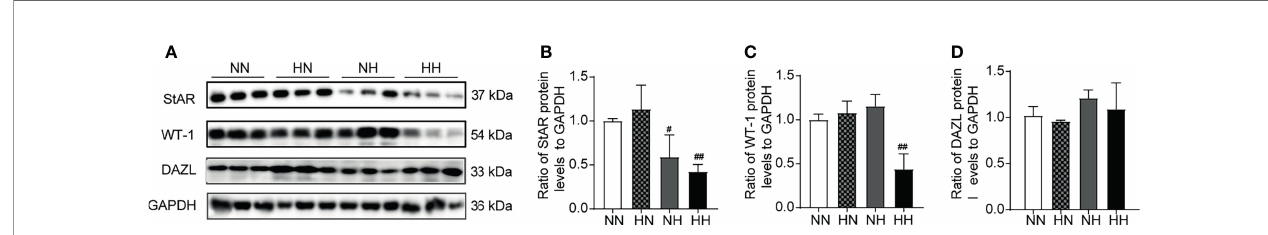
FIGURE 7 | The expression of synthetic testosterone and spermatogenic enzymes induced by a high-fat diet during sexual development. (A) The bands of Western blotting analysis of StAR, WT-1, DAZL in mice testes. Testis lysates (40 µg/well) were loaded onto gel and reacted with primary and later secondary antibodies; GAPDH was set as loading control. The panel (B – D) is a densitometric histogram of protein bands and results were expressed as ratio of corresponding protein to GAPDH (n=3 for each group). Results are presented as mean ± SEM. #p < 0.05, ##p < 0.01 vs the NN group. All of the above panels are representative of 3